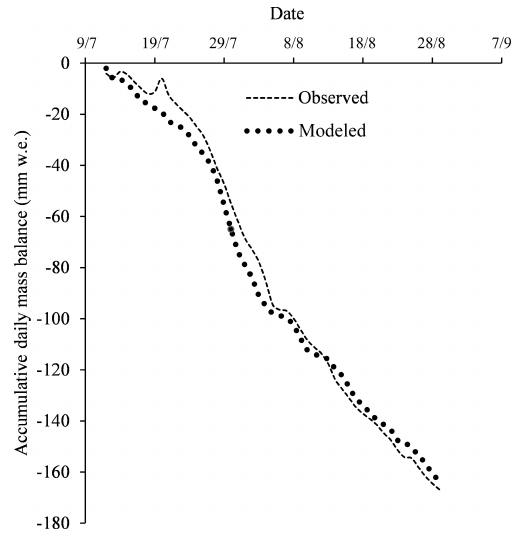
Figure 10. Comparison of observed daily mass balance and mod- eled daily mass balance. Mass balance measurements were taken from 12 July to 29 August. Measurements of surface lowering were converted into water equivalents using density values.